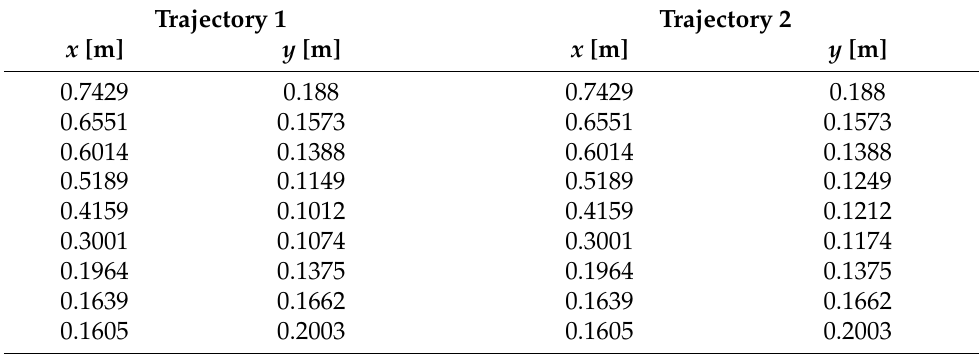
Table A1. Cartesian coordinates of the precision points for both trajectories in study case